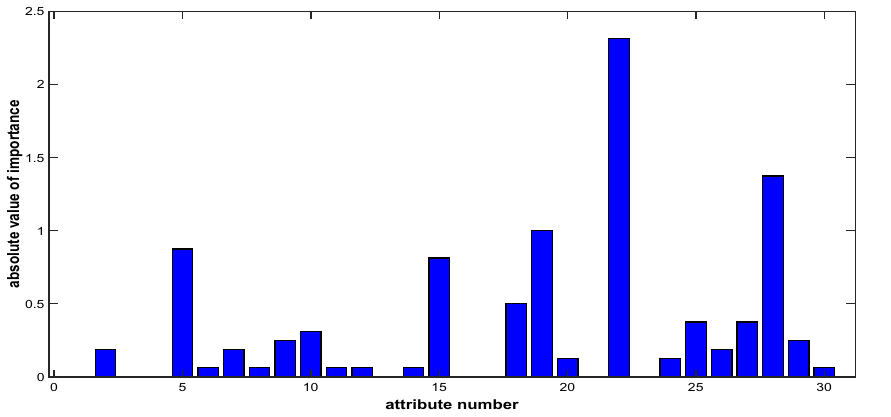
Figure 3. Comparison chart of absolute value of